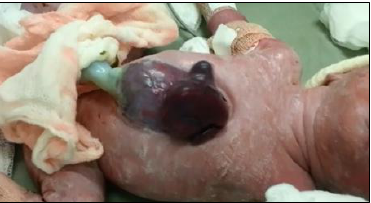
Figure 2: Photo of the newborn showing omphalocele and ectopia cordis. Within 11hr of life, the authors opted for surgical correction, which comprised opening of the remnant of the manubrium, total thymectomy, wide opening of both the pleura, resection of the remaining pericardium, bilateral deinsertion of the last three costal arches, and bilateral wide release of a skin flap from the midline to the anterior axillary line. Using these maneuvers, the heart could be accommodated into the chest cavity; the epigastric omphalocele was corrected with abdominal flap rotation and coverage of the diaphragm with a silicon mesh. Chest tubes were bilaterally placed; an orogastric and urinary catheter was placed, and phlebotomy was